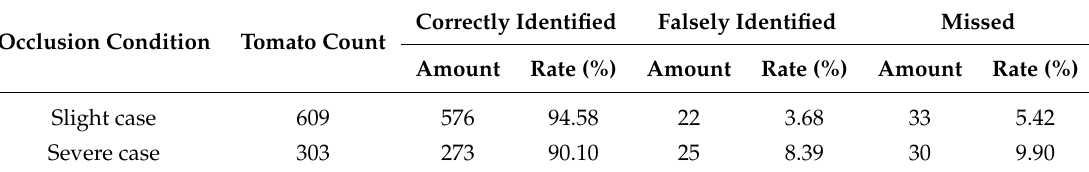
Table 4. The performance of the proposed model under different occlusion conditions.